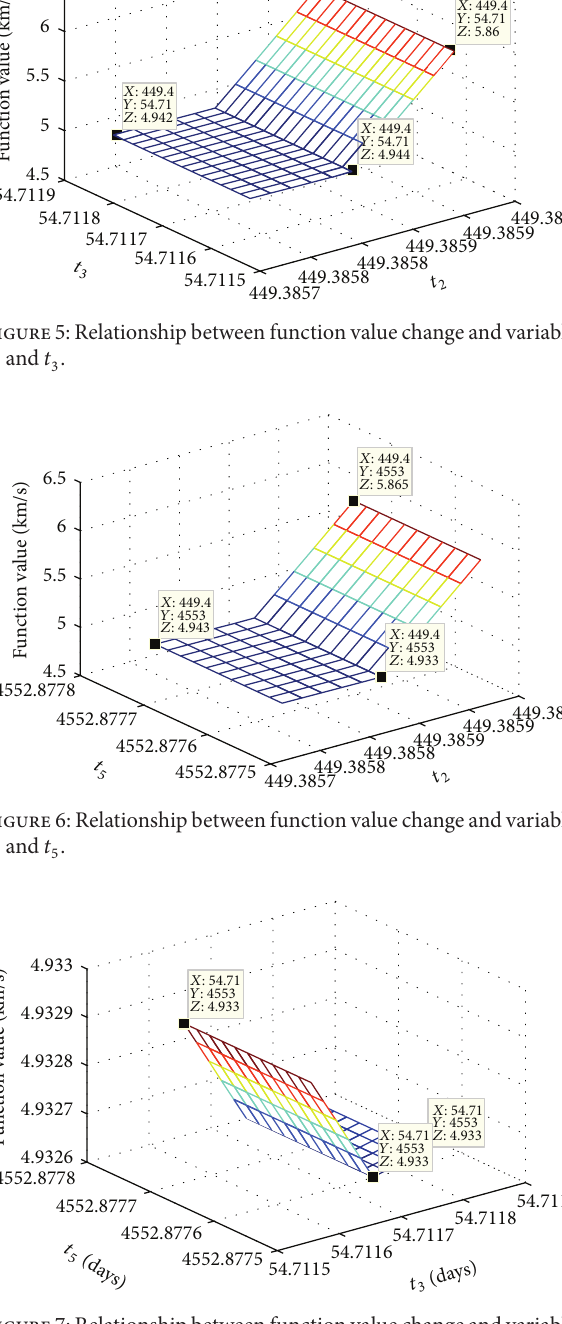
distribution of search space through this statistical